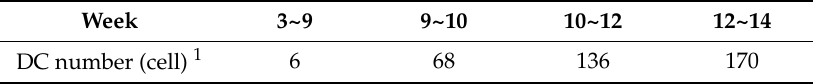
Table 2. The number of DCs in pancreatic